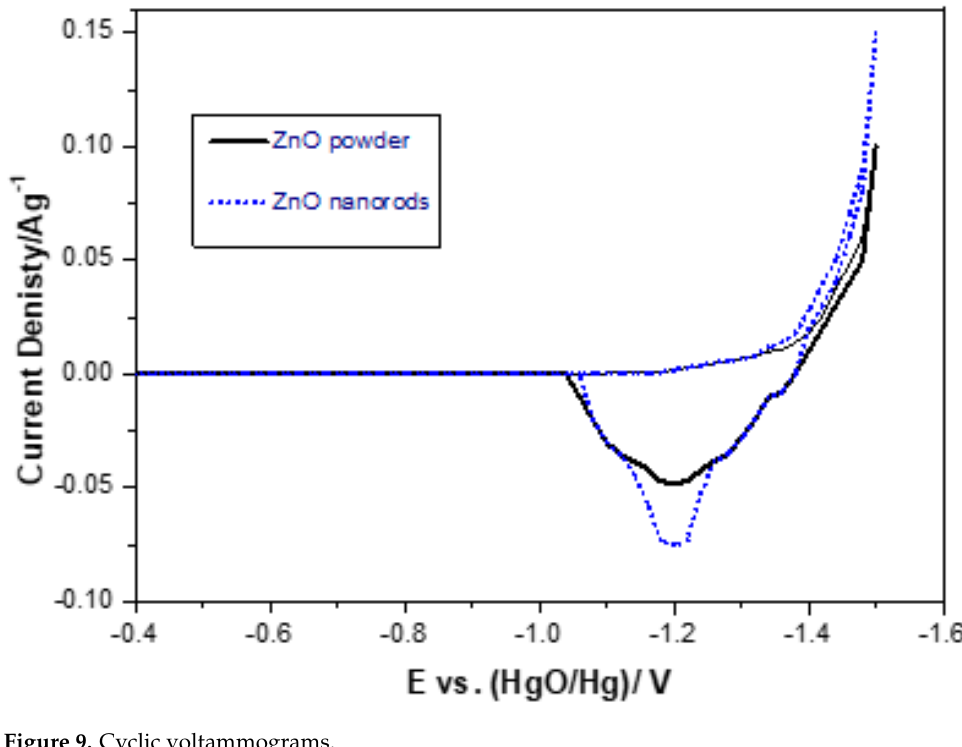
Figure 9. Cyclic voltammograms. Table 2. The data of the CV curves for zinc electrodes with ZnO powder and ZnO nanorods.